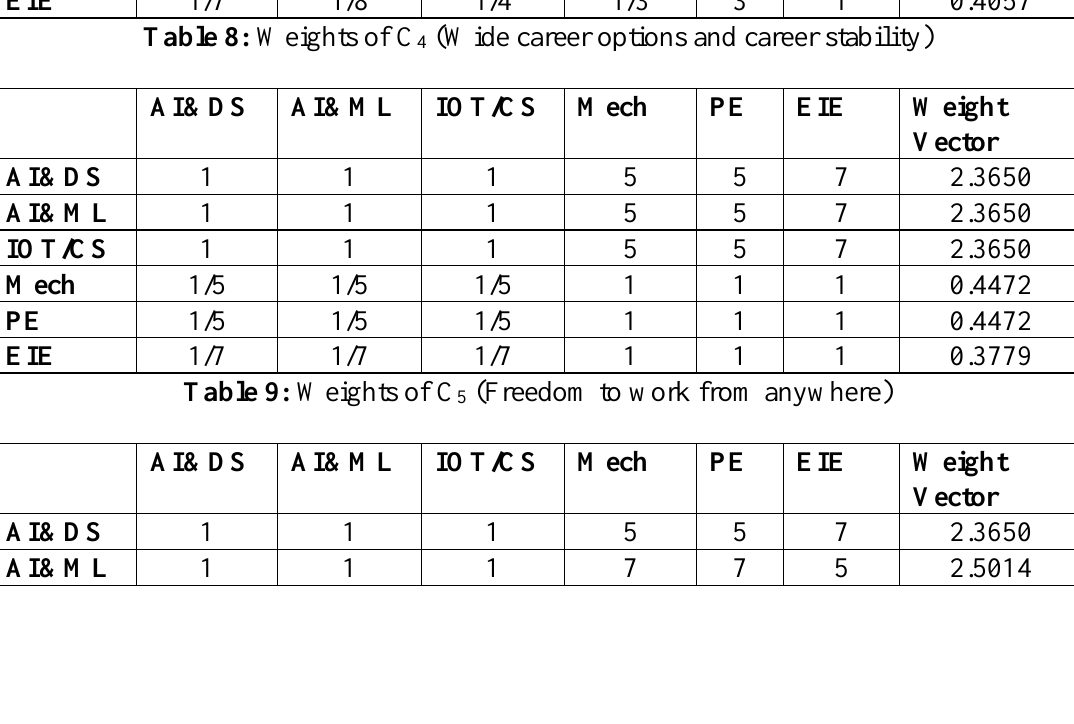
Table 8: Weights of C